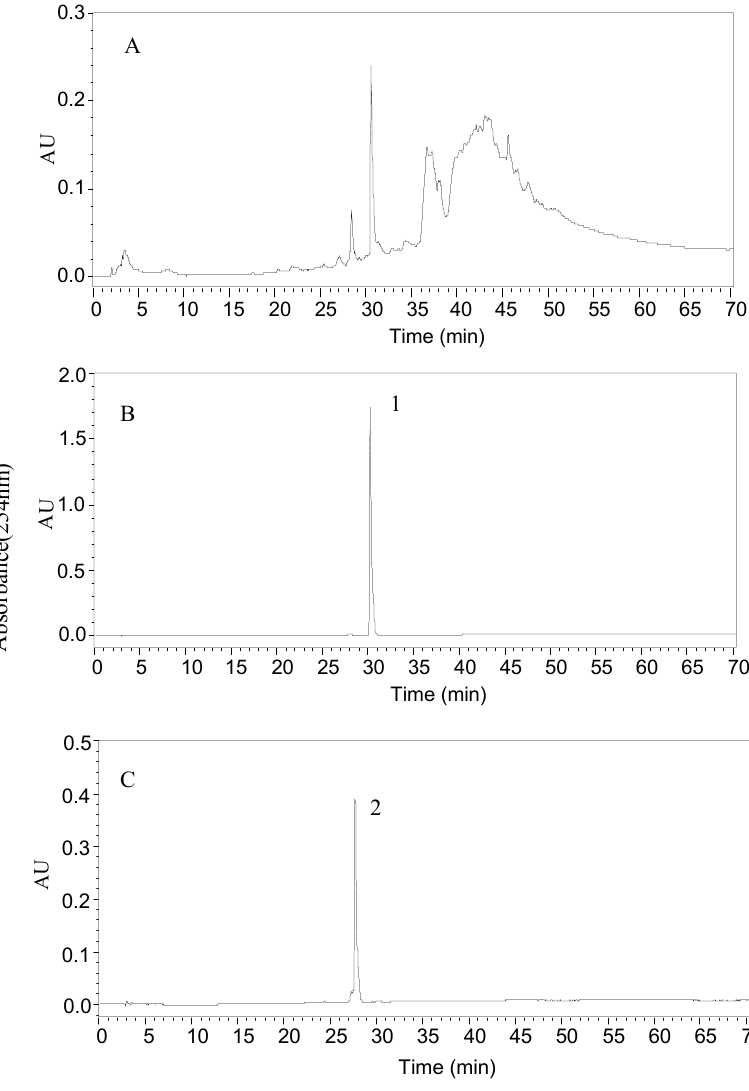
Figure 3. HPLC chromatograms ( A ) CHCl fraction; ( B ) HSCCC fraction of peak 1 ( C ); 3 HSCCC fraction of peak 2. Conditions: column, Zorbax SB-C18 column (250 mm × 4.6 mm, I.D., 5 µm, Agilent); column temperature, 25 °C; mobile phase, methanol and water